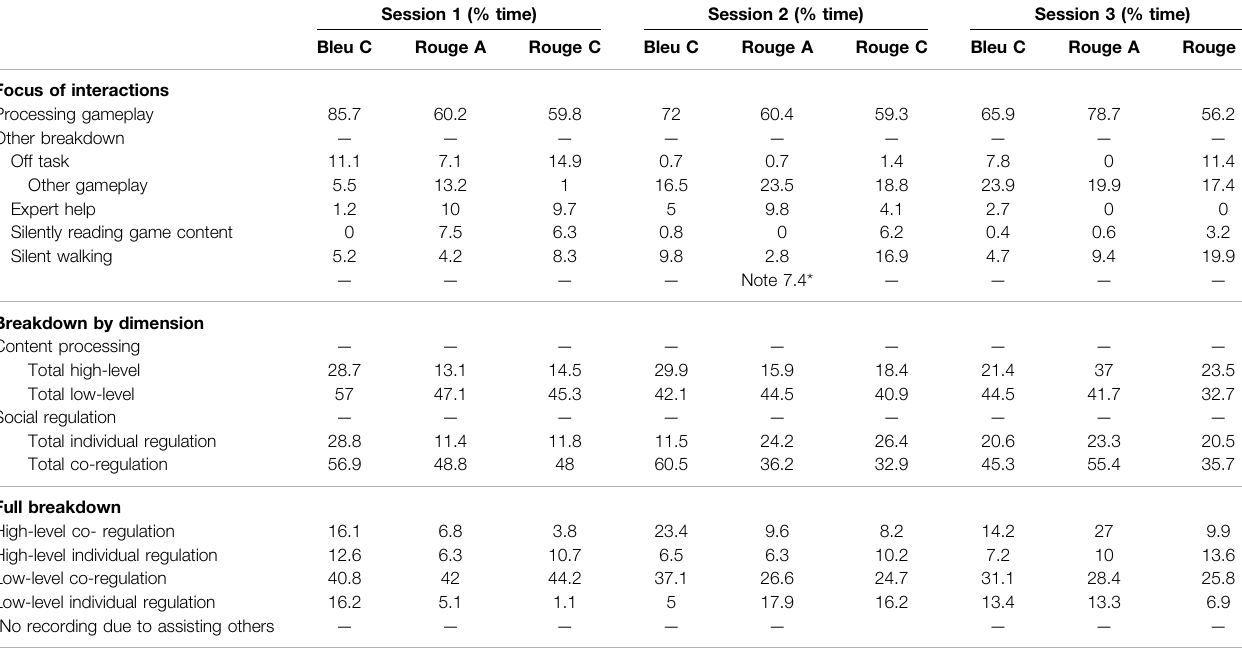
TABLE 4 | Fran 160 cohort ’ s focus and percentage of time on interactions by three groups in the three sessions. Session 1 (% time)